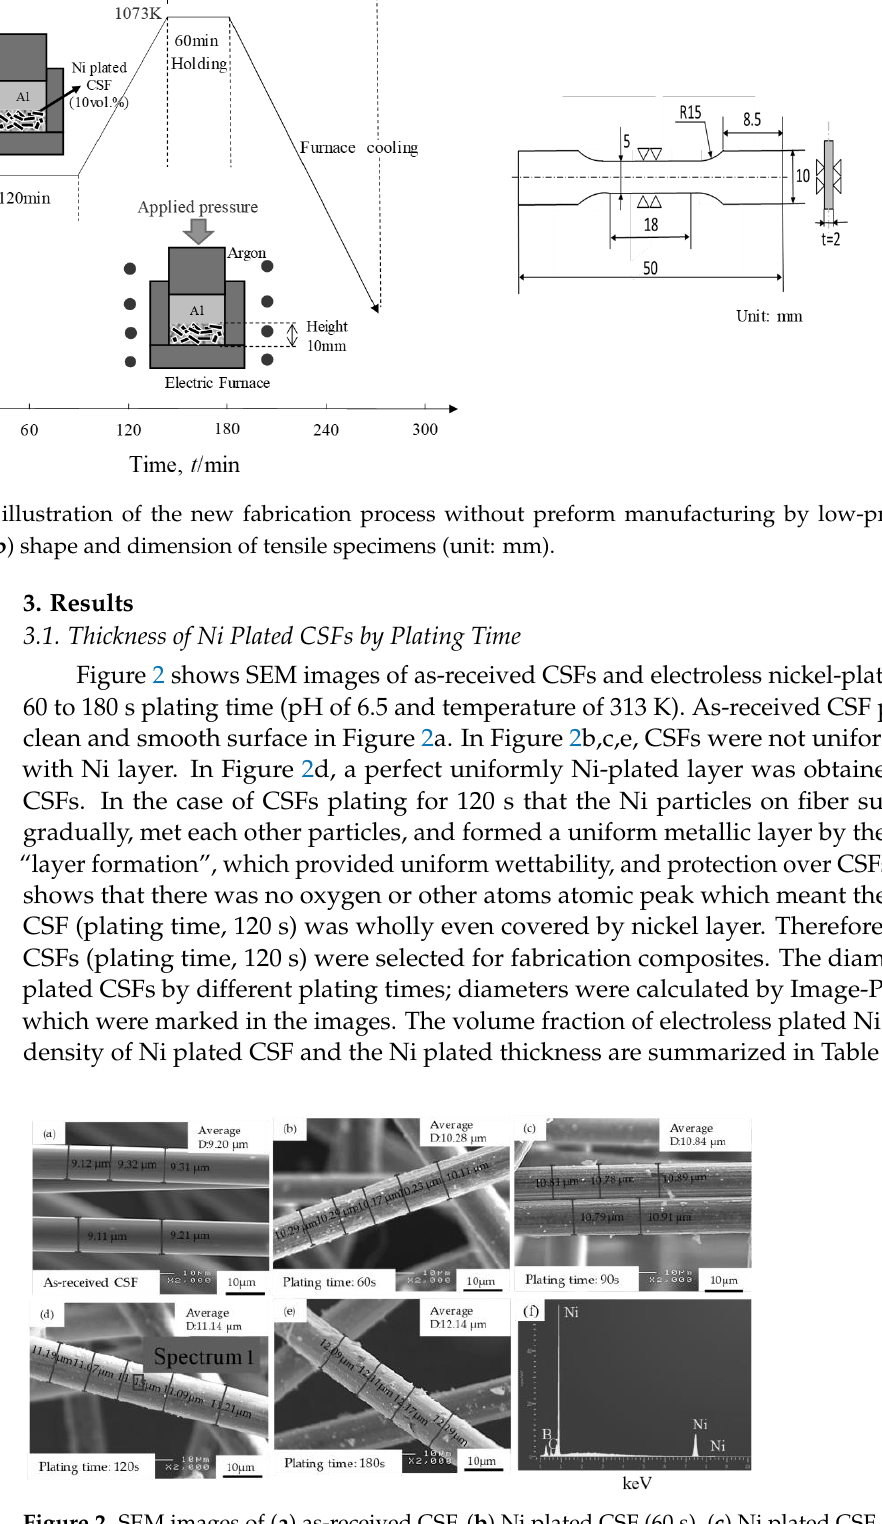
Figure 2. SEM images of ( a ) as-received CSF, ( b ) Ni plated CSF (60 s), ( c ) Ni plated CSF (90 s), ( d )